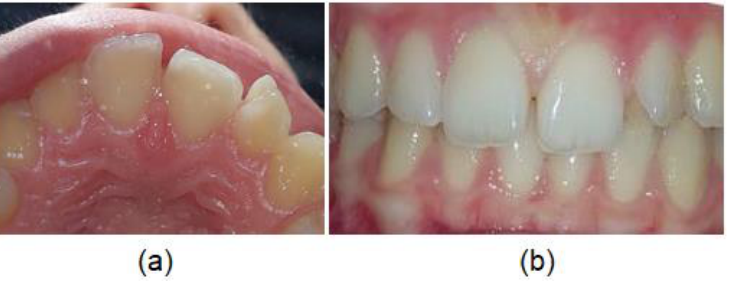
Figure 4. Talon cusp: ( a ) on the palatal surface of the permanent maxillary lateral incisor and ( b ) disturbed occlusion.